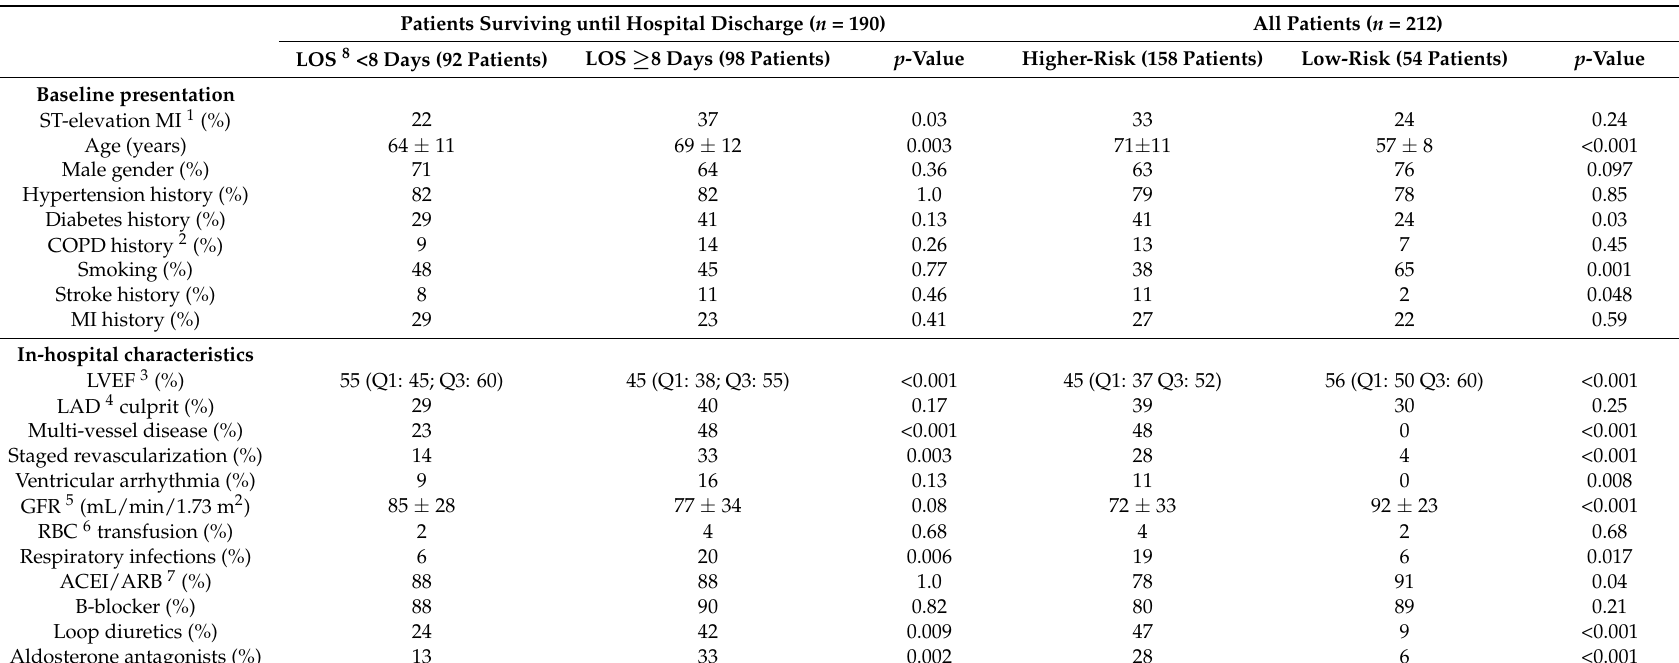
Table 1. Baseline and in-hospital clinical